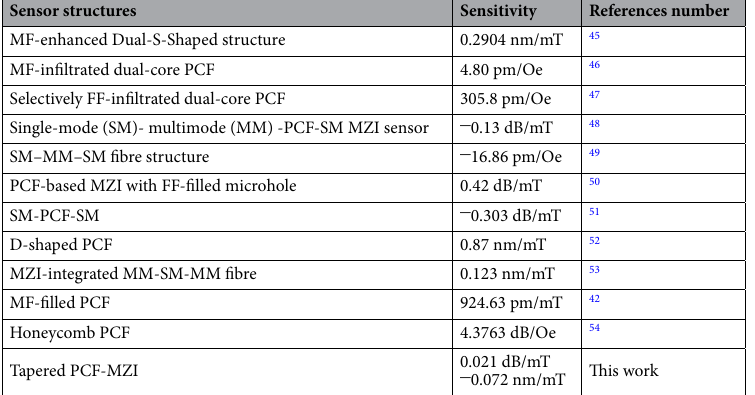
Table 1. Sensitivities of some of the PCF-based magnetic field